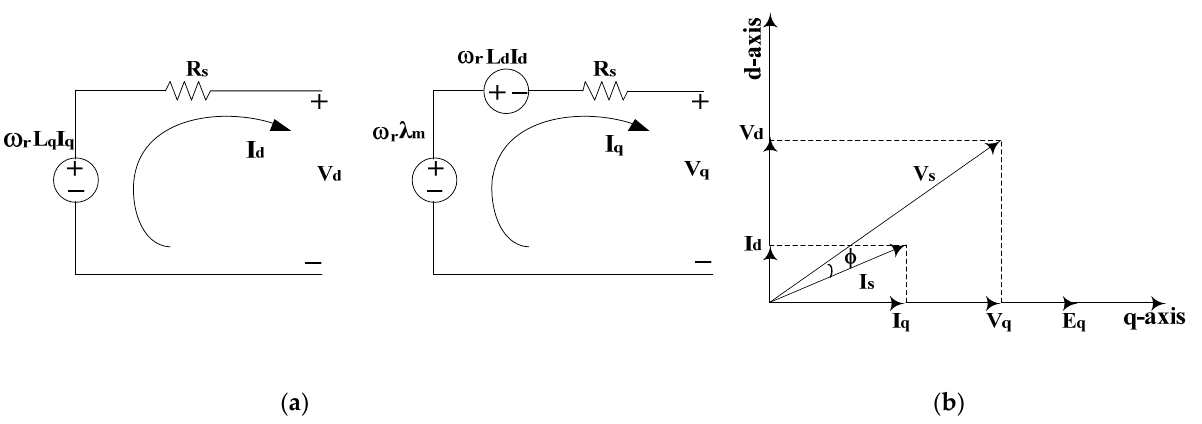
Figure 2. Dq modeling of FRG: ( a ) equivalent circuit, and ( b ) phasor diagram.